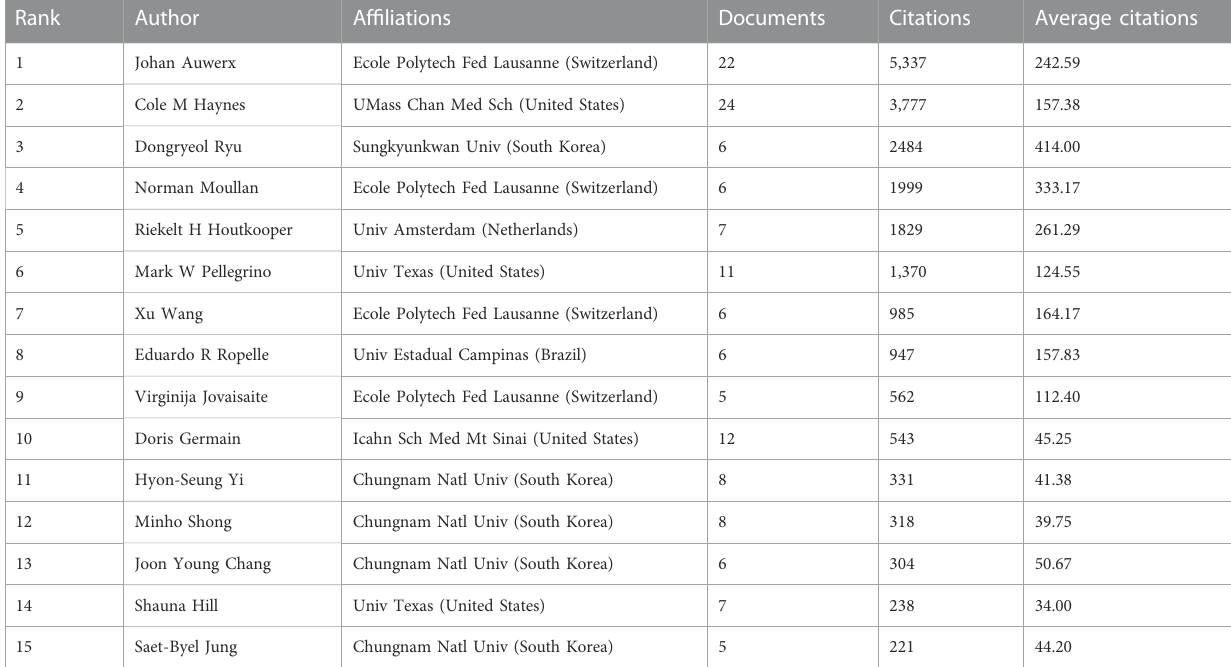
TABLE 2 Top 15 most cited authors in the fi eld of UPR mt